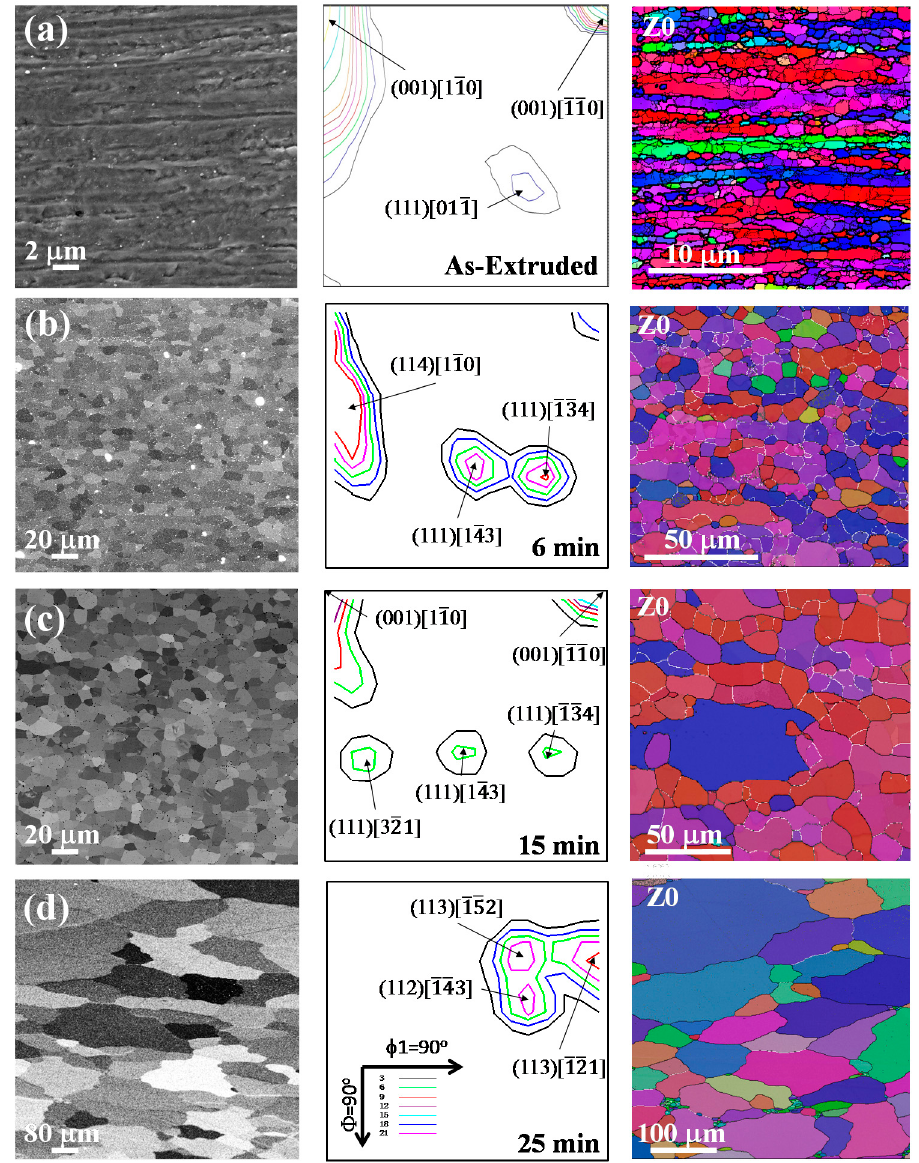
Figure 2. SEM image of longitudinal sample, φ 2 = 45 ◦ section of ODF (Orientation Distribution Function), and EBSD map of recrystallization-annealed microstructure: ( a ) as-extruded; and after ( b ) 6 min, ( c ) 15 min, and ( d ) 25 min. The black solid lines in EBSD maps represents the HAGB; meanwhile, the finer white solid lines represents the LAGBs. Please note that scale bars are different.